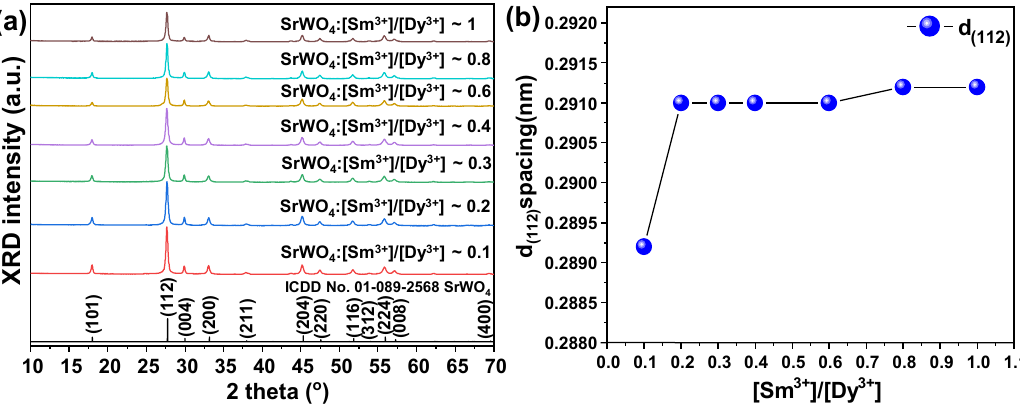
3+ ]/[Dy 3+ ] and ( b ) d (112) spacing of